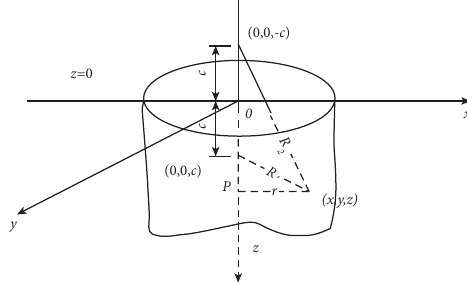
Figure 1: Concentrated force in the